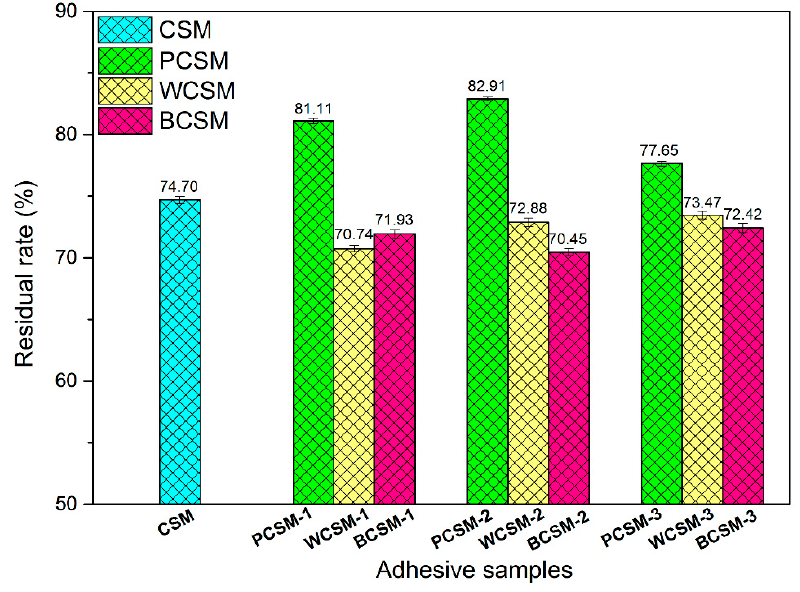
Figure 5. The residue rate of CSM and PCSM, WCSM, Band CSM adhesive samples.